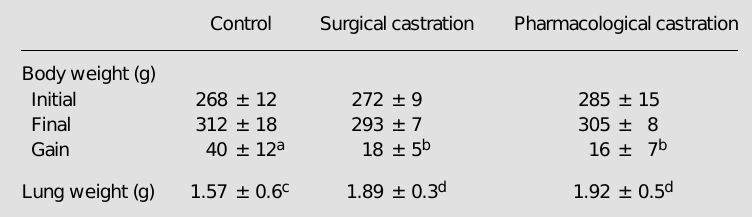
Table 1 - Body and lung weights of rats after surgical and pharmacological castration. Data are reported as means ± SD, N = 8 for each case. Across a row, values with different superscript letters indicate significant differences by analysis of variance and the Tukey test. a,b,c,d